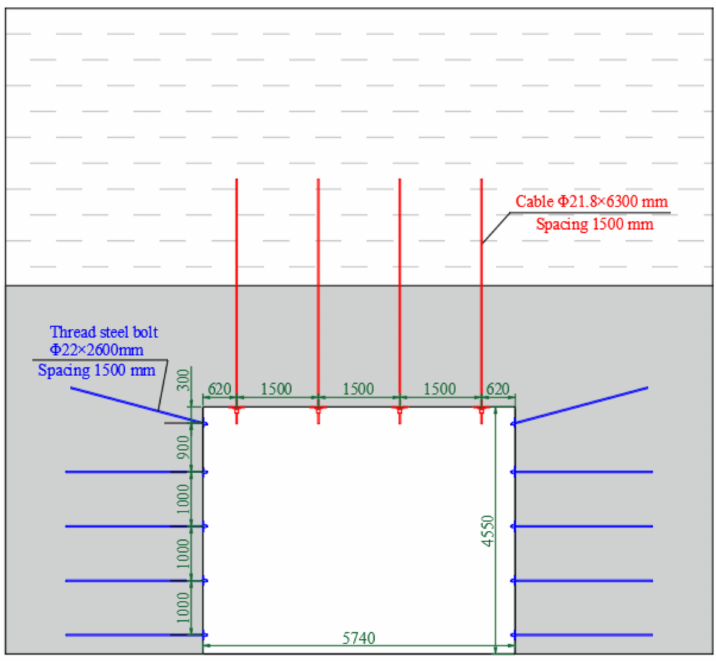
Figure 13. Optimized support